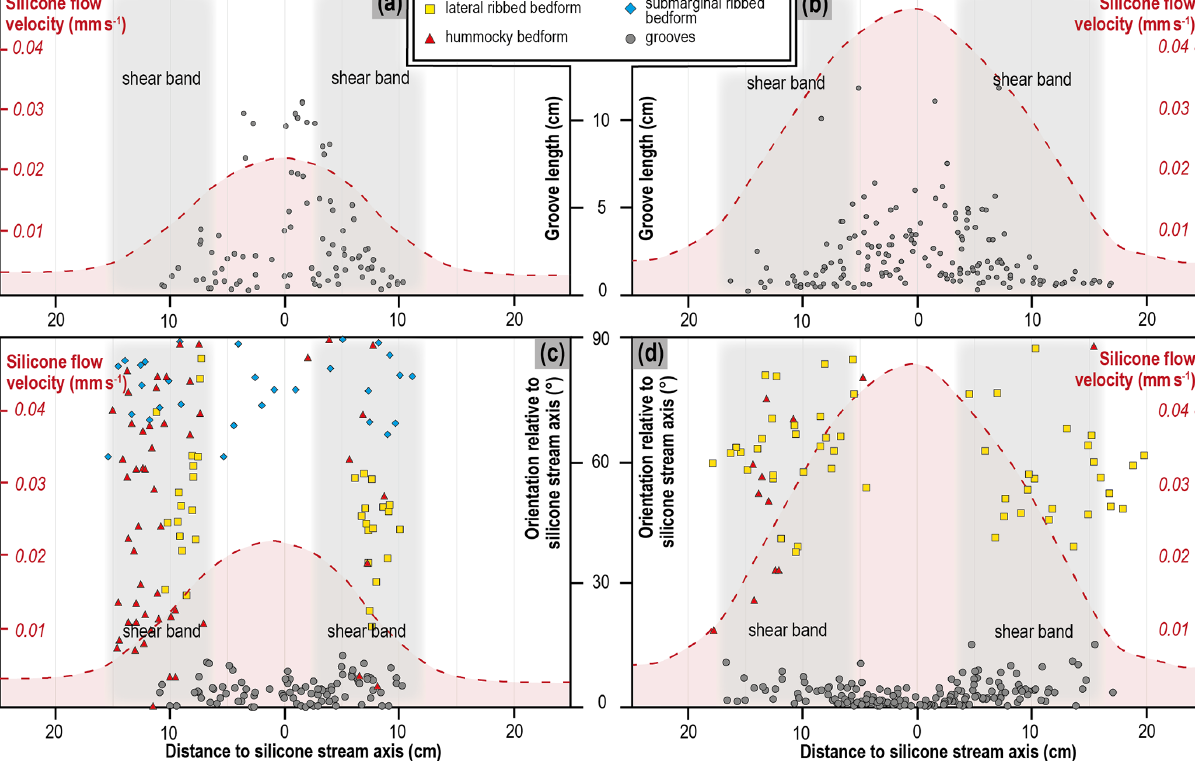
Figure 11. Morphometric properties of bedforms produced beneath each type of stream at the final stage of experiments 10 (b, d) and 14 (a, c) plotted according to the distance from the silicone stream central axis. (a, b) Relationship between groove length and silicone flow velocity (mms − 1 ). (c, d) Variation in orientation relative to silicone stream axis of each population of bedforms (lateral ribs, submarginal ribs, hummocky) compared to the silicone flow velocity and the shear band position (grey columns; defined as ε shear > 0 . 5 × 10 − 4 s − 1